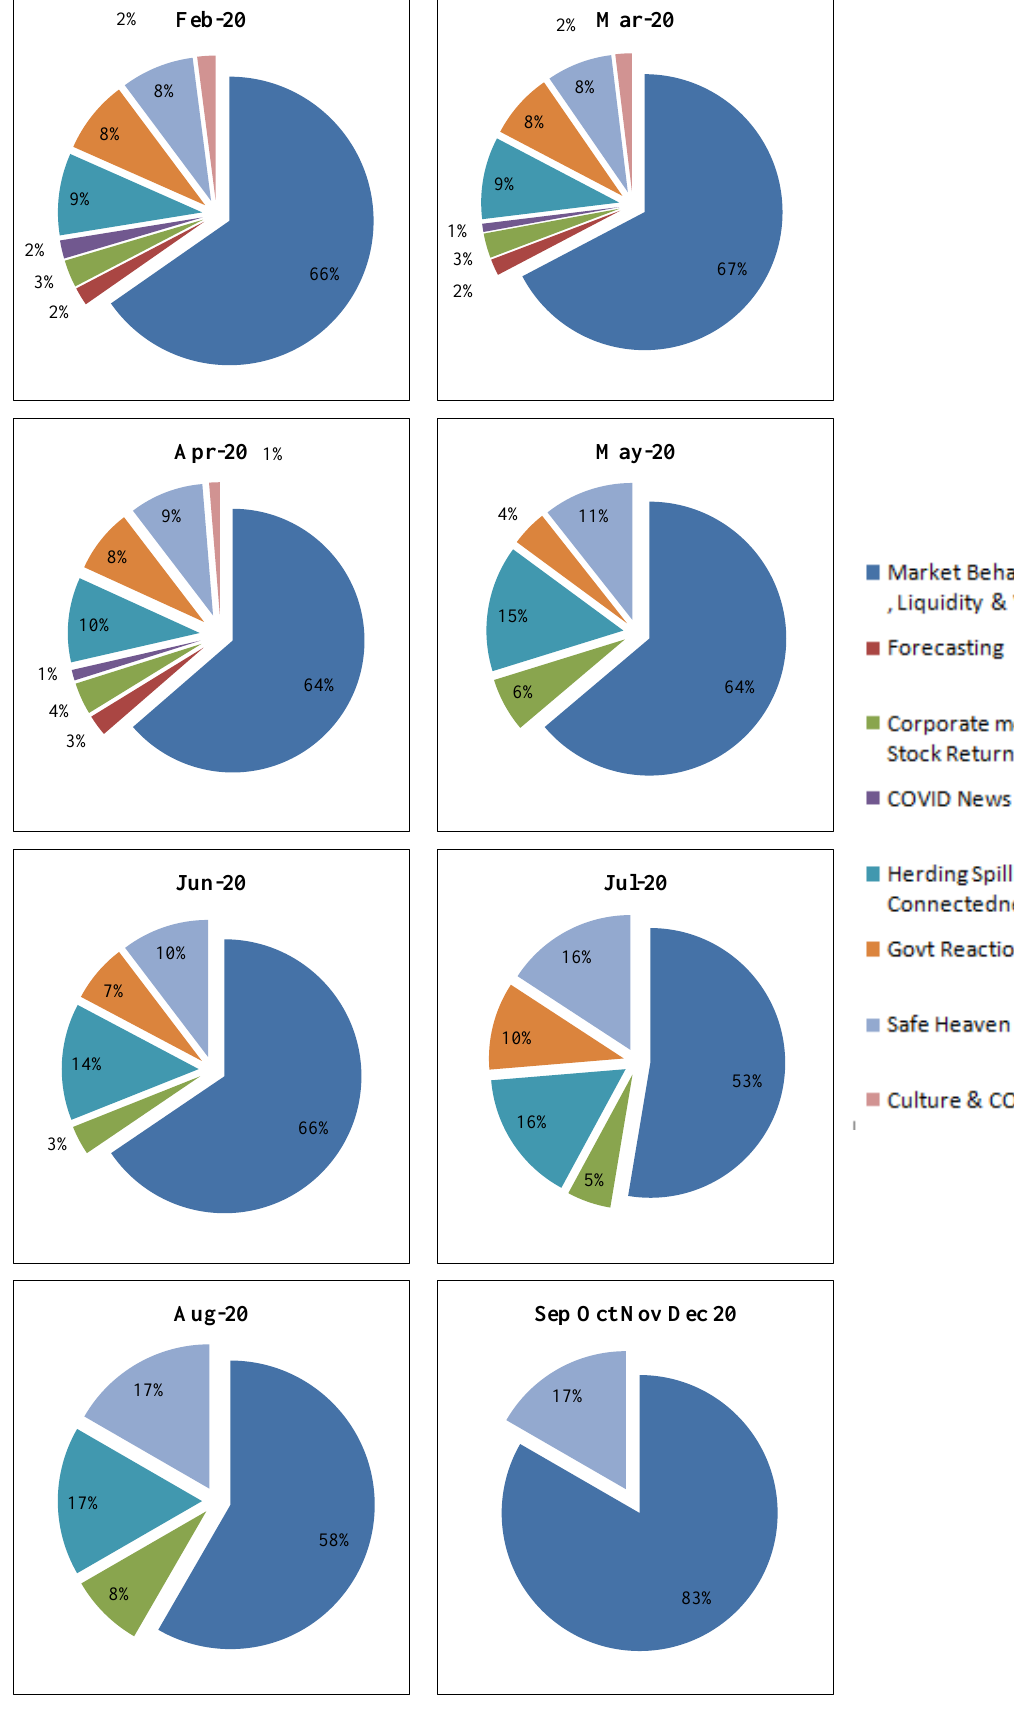
Figure 11. Themes of Research used in Research in Crisis